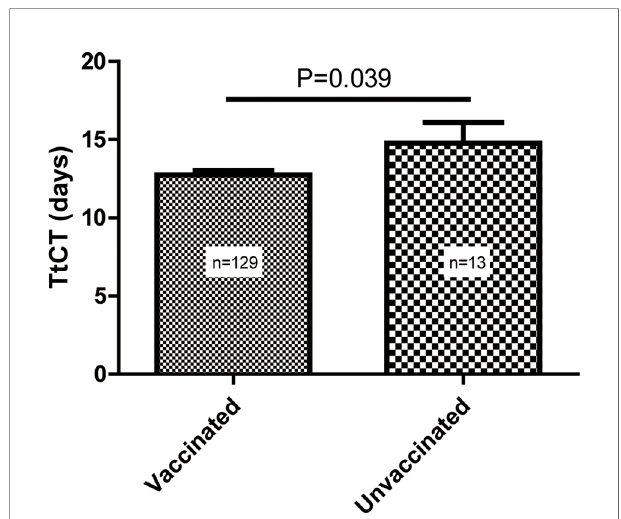
FIGURE 1 | Difference in the time to target cycle threshold value (TtCT) between the vaccinated and unvaccinated individuals.